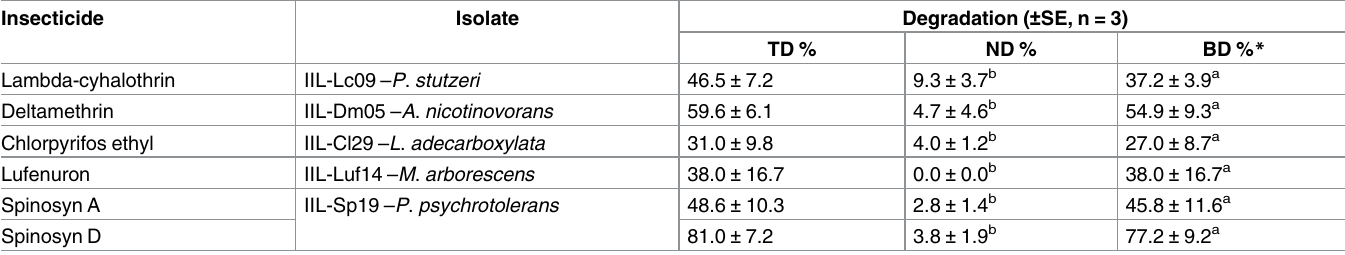
Table 3. Natural (ND), bacterial (BD) and total (TD) degradation of lambda-cyhalothrin, deltamethrin, chlorpyrifos ethyl, lufenuron and spinosad (spinosyn A e D) after 5 days of cultivation of bacterial isolates from the larval gut of insecticide-resistant lines of Spodoptera frugiperda .